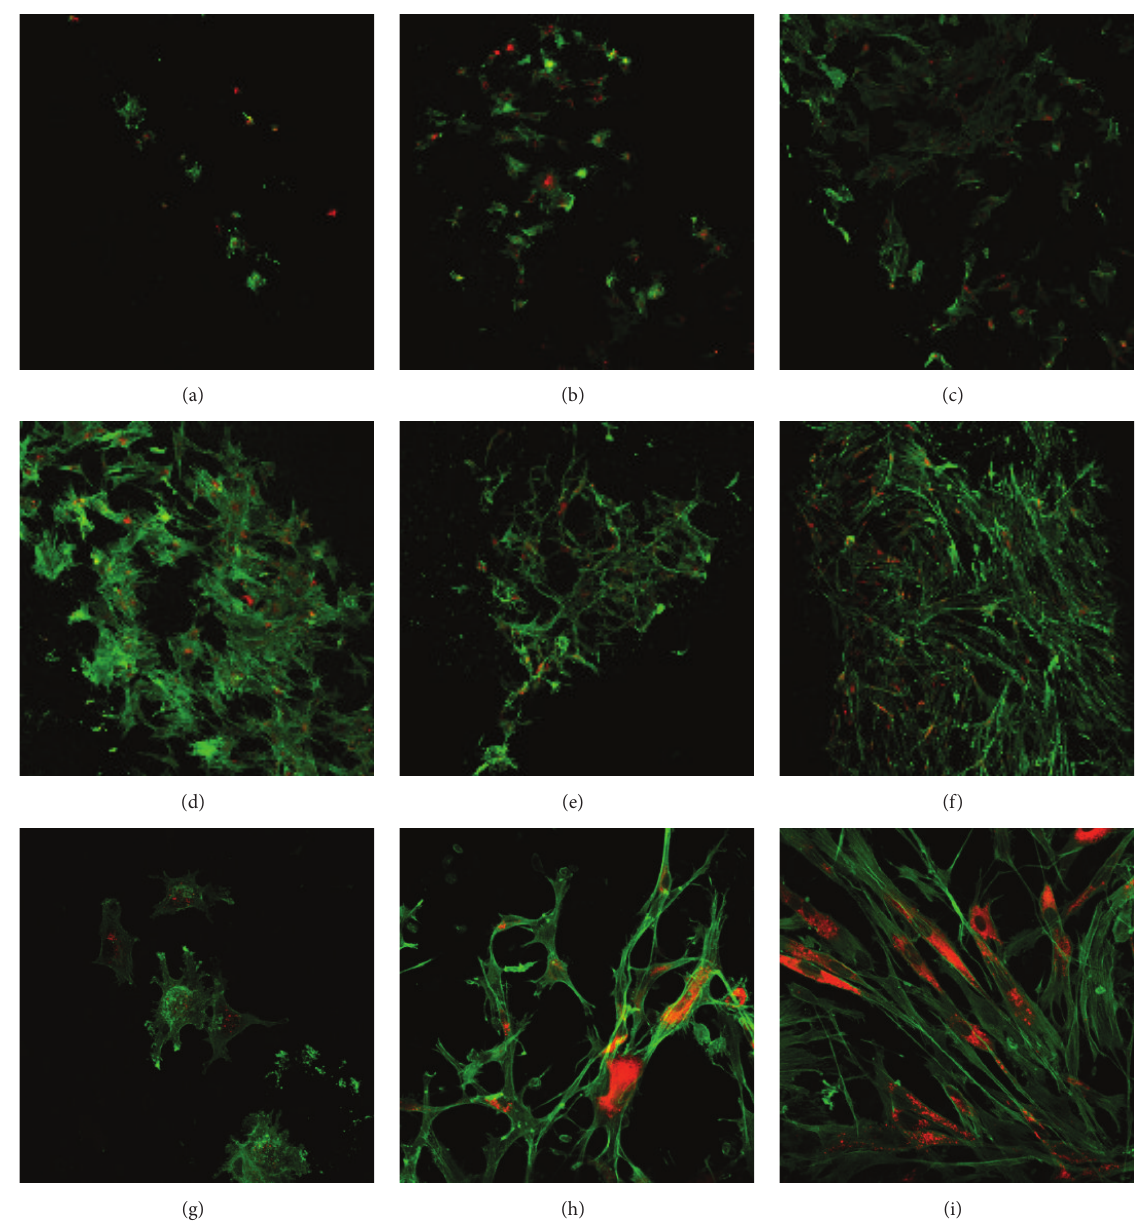
Figure 4: Cartilage adherence time course of MSCs. MSCs were cultured until the second passage before use in this experiment. Prior to seeding cells for the time course, the monolayer was washed in PBS and then stained using CM-DiI (orange colour) membrane dye. Cartilage discs were used to plug the bottom of a 96-well plate in the correct orientation. Cells were then stripped using TrypLE, counted using the standard enumeration technique, and then seeded onto the cartilage discs at a density of 5 × 10 3 cells/disc and the 96-well plate was then incubated at 37 ∘ C and 5% CO 2 . At each of the time points (1, 2, 3, 4, 8, and 24 hours), the cartilage discs were washed in PBS and then fixed in 4% paraformaldehyde and then washed in PBS. Cartilage discs with attached cells were then permeabilised in 0.1% Triton X-100, washed in PBS, and blocked in 1% Bovine serum albumin in PBS before being stained with F-actin-specific Alexa Fluor 488-phalloidin (green). All images were taken using the OLYMPUS FLUOVIEW FV1000 IX81 inverted confocal microscope. (a) One-hour time point at 10x magnification, (b) two-hour time point at 10x magnification, (c) three-hour time point at 10x magnification, (d) four-hour time point at 10x magnification, (e) eight-hour time point at 10x magnification, (f) 24-hour time point at 10x magnification, (g) one-hour time point at 40x magnification, (h) eight-hour time point at 40x magnification, and (i) 24-hour time point at 40x